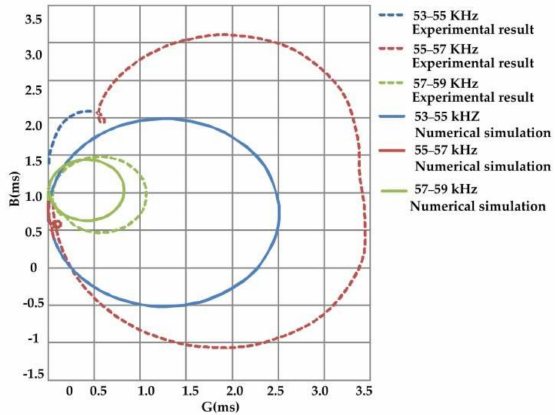
Figure 14. Impedance experiment and simulation results admittance